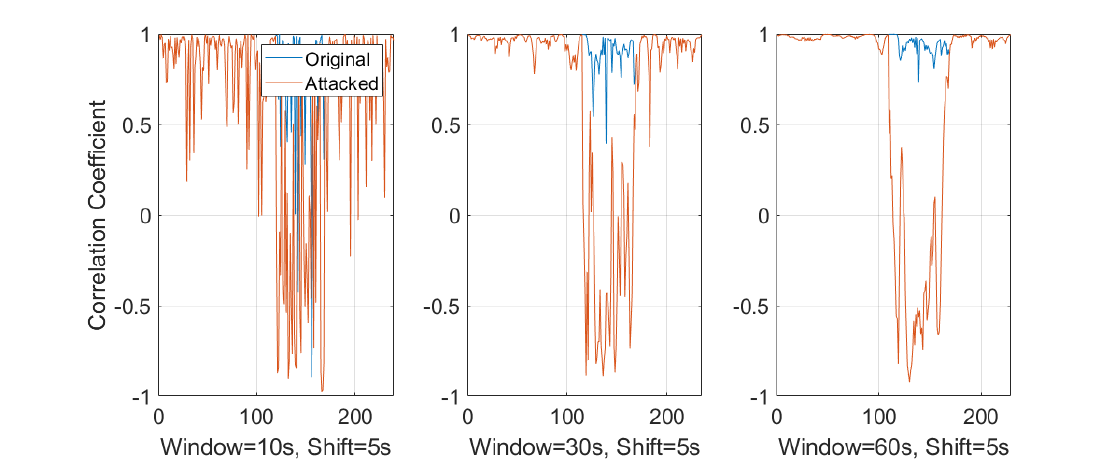
Figure 13. Correlation coefficient with 10 s, 30 s, and 60 s sliding window with a shift step size of 5 s.